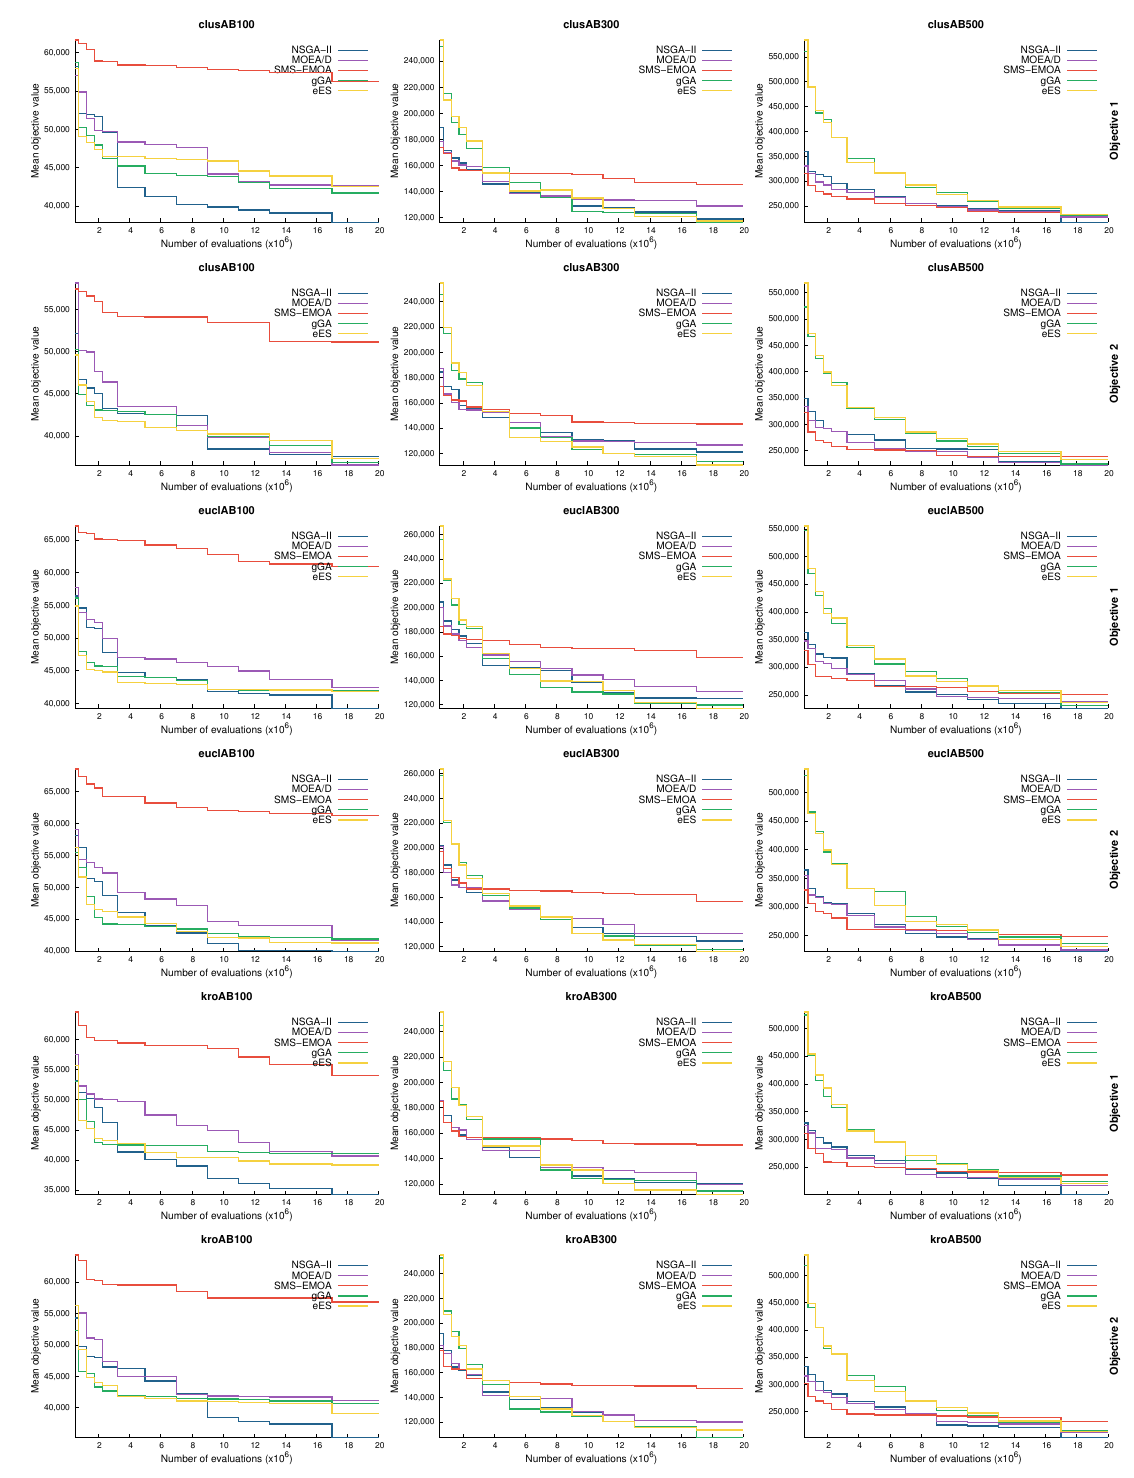
Figure 3. TSP evolution of the mean fitness for objectives 1 and